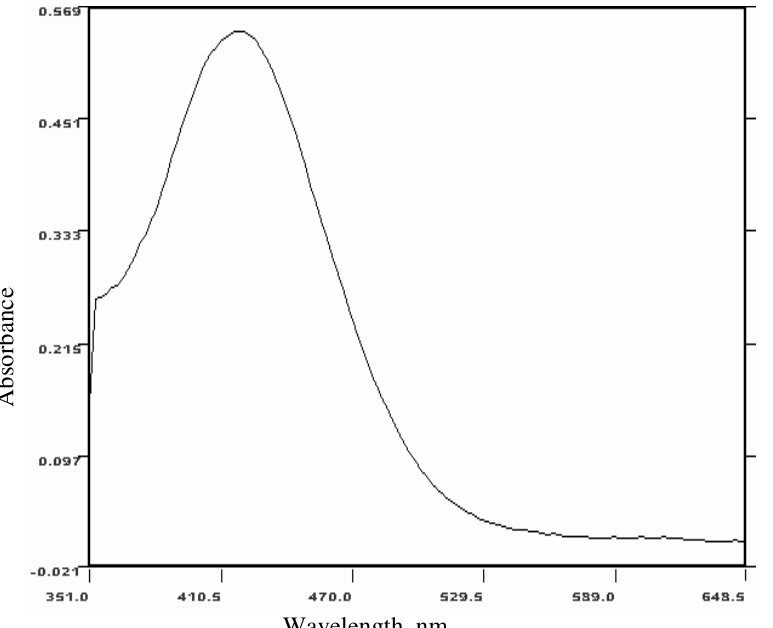
Figure 2 . Absorption spectra of OXA-BCG complex extracted into 10mL chloroform: (OXA = 30 µ g mL -1 + 1 mL of 0.12 % (w/v) BCG + 2 mL of pH 4 buffer against